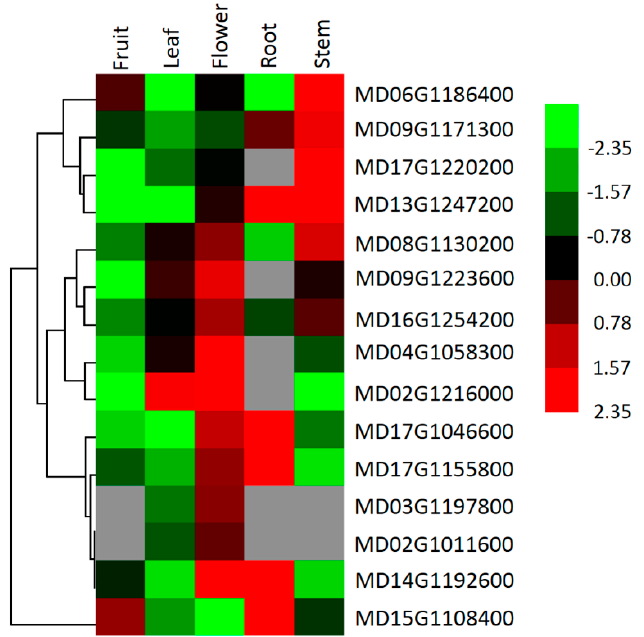
Figure 4. Expression profiles of apple P 3A -Type ATPase genes in five kinds of tissue, Fruit (ripening fruit), Leaf (mature leaf), Flower (full-bloom flower), Root, and Stem. The heat map was generated via Mev software using relative expression data, which are expressed as normalized log 2 transformed values. The hierarchical cluster indicates the differential expression pattern.